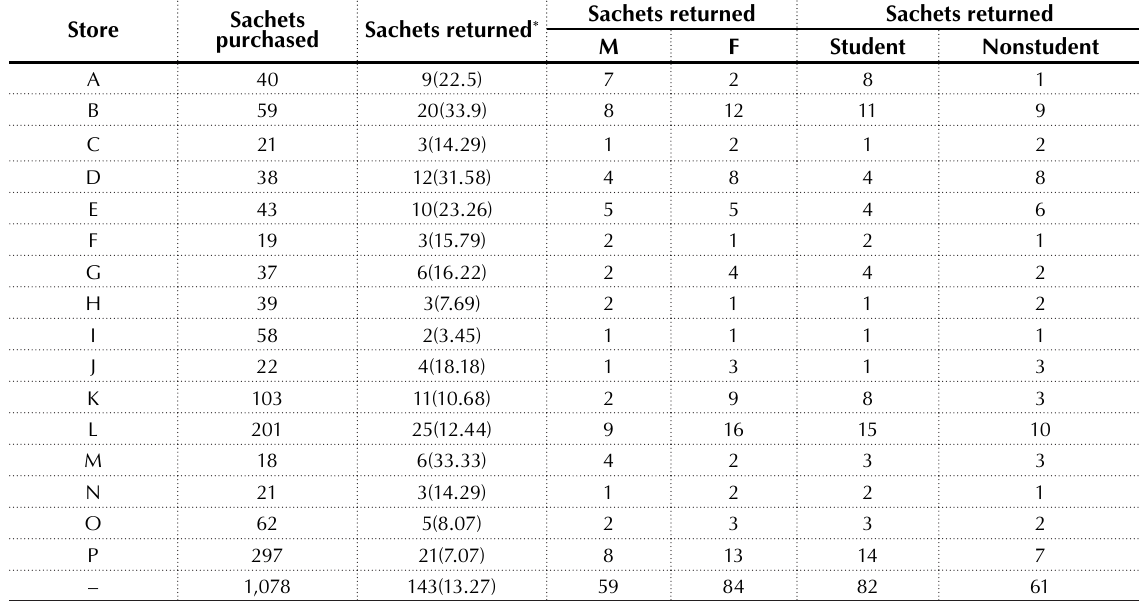
Table 3. Number of sachets purchased and returned by the comparison